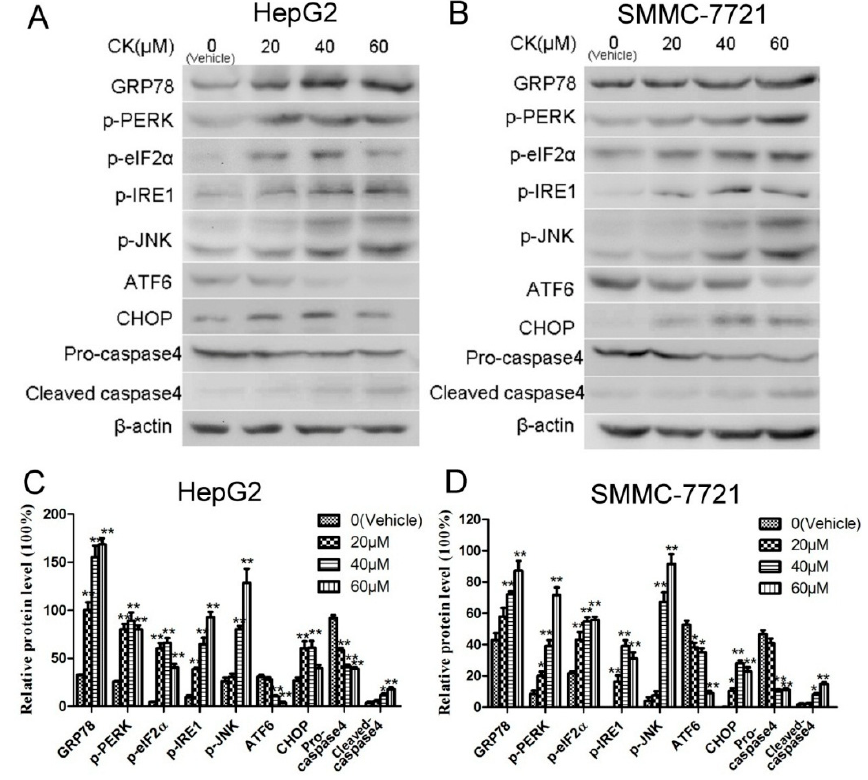
Figure 4. CK induced ERS and evoked UPR in HepG2 and SMMC-7721 cells. ( A , B ) Western blot analysis of GRP78, p-PERK, p-eIF2 α , p-IRE1, p-JNK ATF6, CHOP, and caspase 4. ( C , D ) Quantification of western blot results in ( A , B ) normalized to β -actin. Data are presented as mean ± SD; Statistics were done by one-way ANOVA and Dunnett text. * p < 0.05, ** p < 0.01 vs. Vehicle.